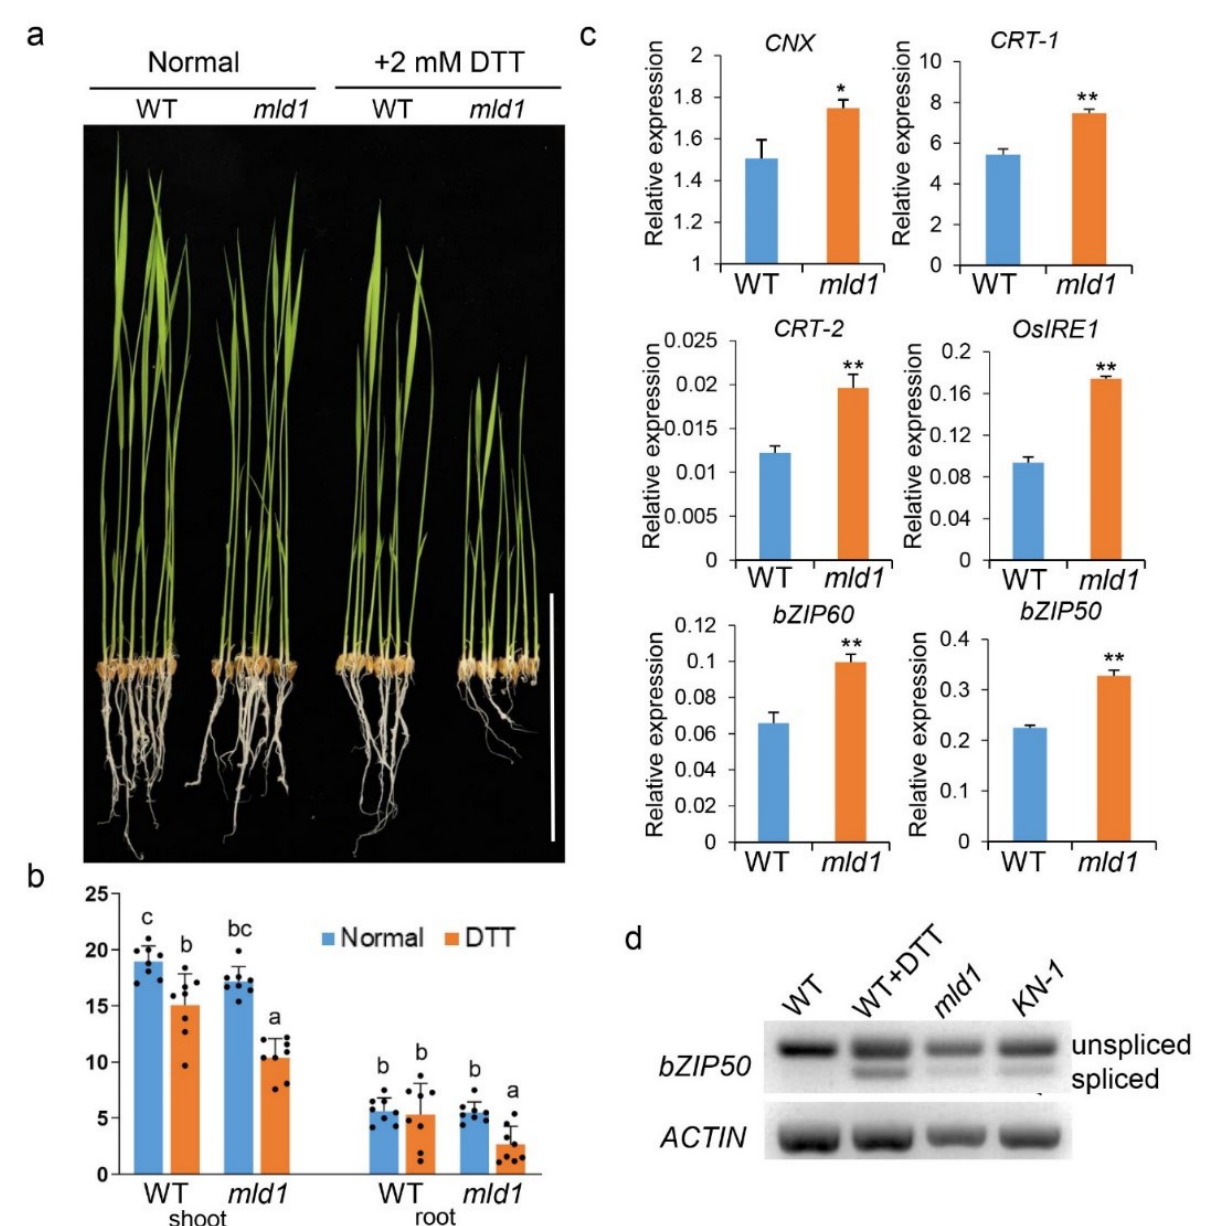
Figure 3. mld1 is more sensitive to ER stress. ( a ) The growth of the WT and mld1 mutant in liquid medium with 2 mM DTT refreshed daily was observed over a period of 7 days. Liquid medium without DTT served as a control. ( b ) Quantitative measurements of the lengths of the shoots and roots of wildtype and mld1 seedlings in three trials. Values are the means ± SD ( n = 8). Significance analysis was performed using two-factor ANOVA with Tukey’s HSD test. Different letters indicate significant differences ( p < 0.05). ( c ) ER stress-induced expression of several genes. mRNA levels of representative ER stress-induced genes in the WT and mld1 seedlings. RT-qPCR analyses of three biological replicates. Data were normalized to the expression of the OsACTIN1 gene. Values are the means ± SD ( n = 3), Significance analysis of the data was performed using Student’s t- test (* p < 0.05,